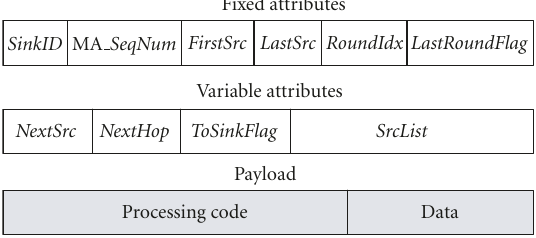
Figure 4: MA packet